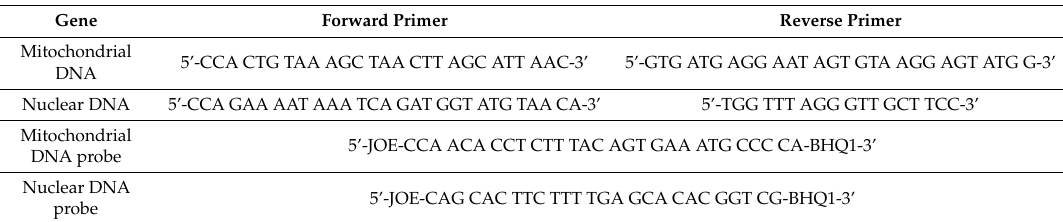
Table 2. The primers related to mitochondrial DNA copy number used to determine the expression of genes by qRT-PCR in this